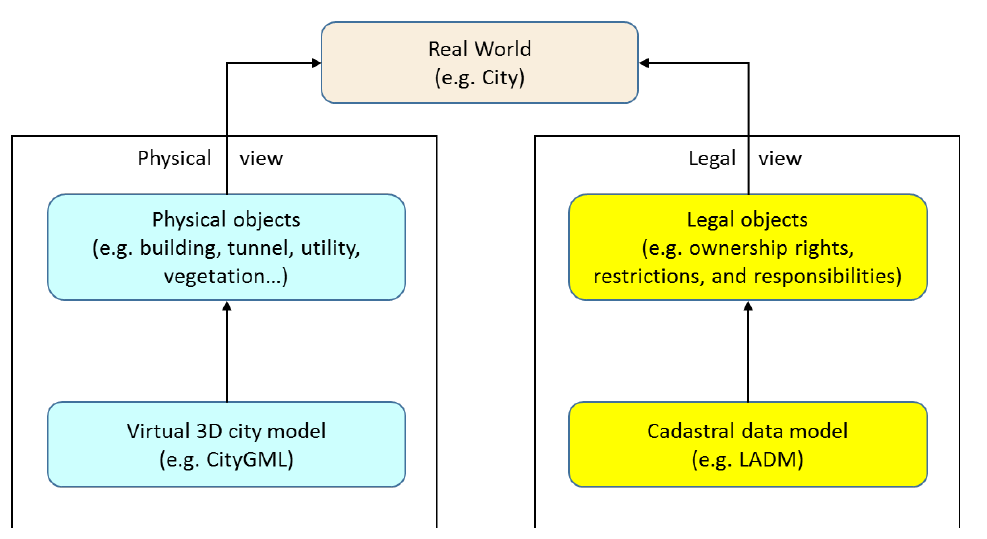
Figure 1. Legal and physical dimensions of an urban